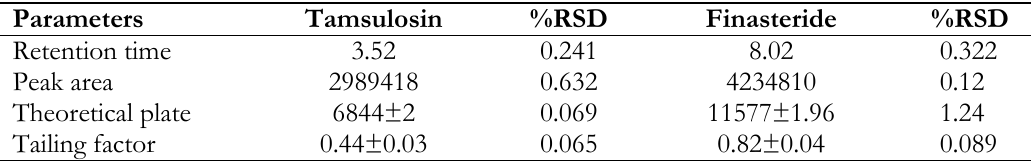
*Each mean value is the result of six analysis Table II. System Suitability parameters